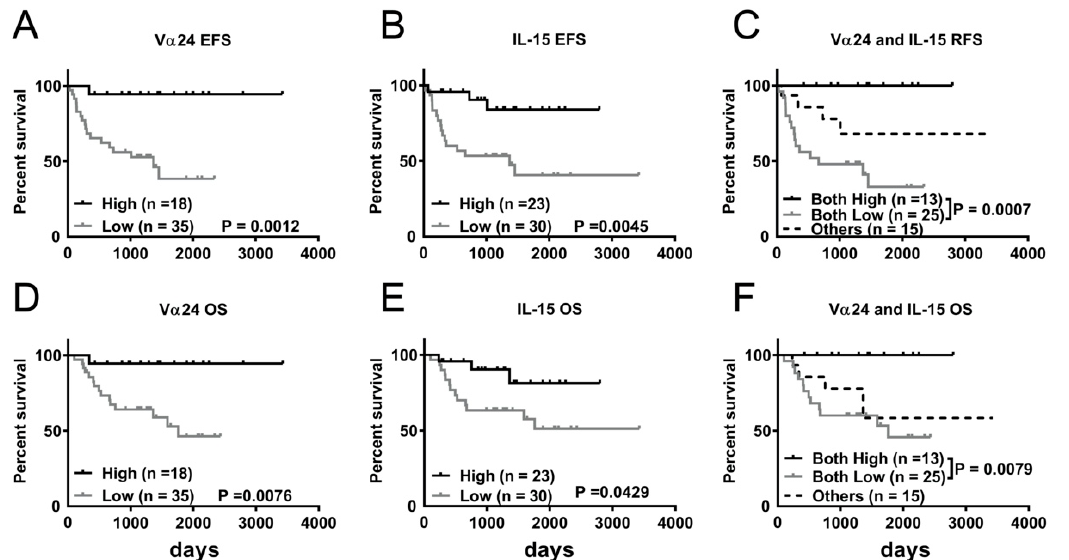
Figure 4. Survival benefit of greater abundance of NKT and IL-15 expression in tumor tissue of NBL patients. Kaplan–Meier curves showing EFS ( A – C ) and OS ( D – F ) of 53 NBL patients according to V α 24 ( A , D ), IL-15 (B,E), and IL-15 + V α 24 combined ( C , F ) expression. Log-rank test was applied for statistical comparison.